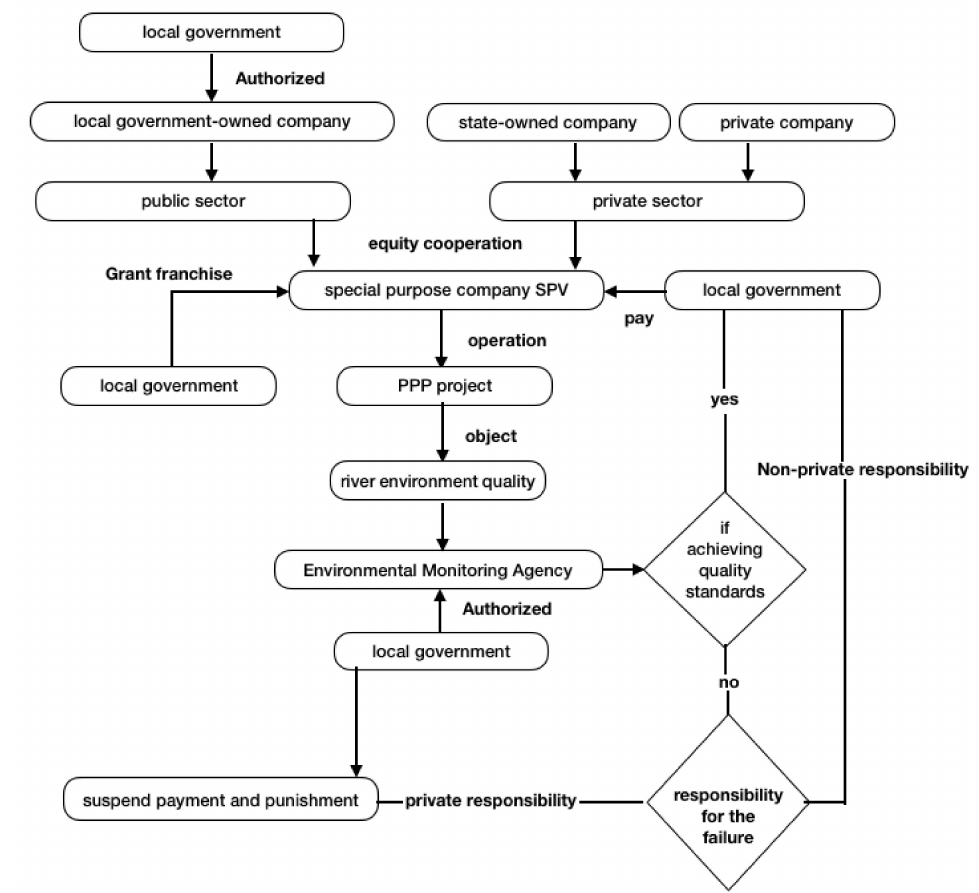
Figure 2. PPP operational